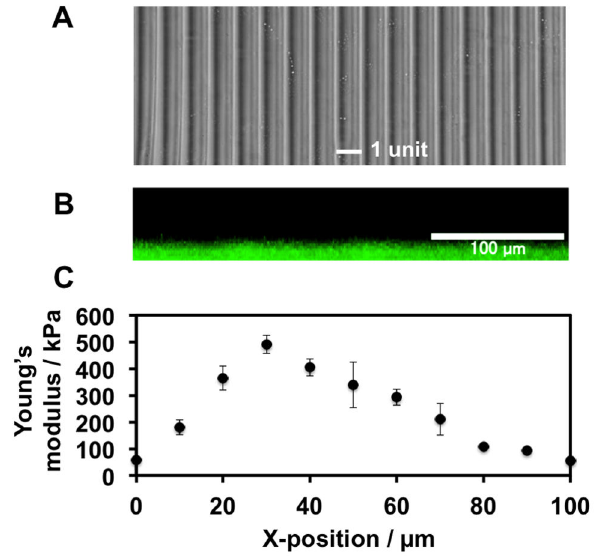
Figure 3. A representative gel with a saw-like asymmetric elasticity pattern. Width of each unit: 100 µm. (a) Phase contrast microscopy image of the gel surface. (b) Cross- sectional observation of the gel surface by confocal laser scanning microscopy. (c) Distribution of Young’s modulus in